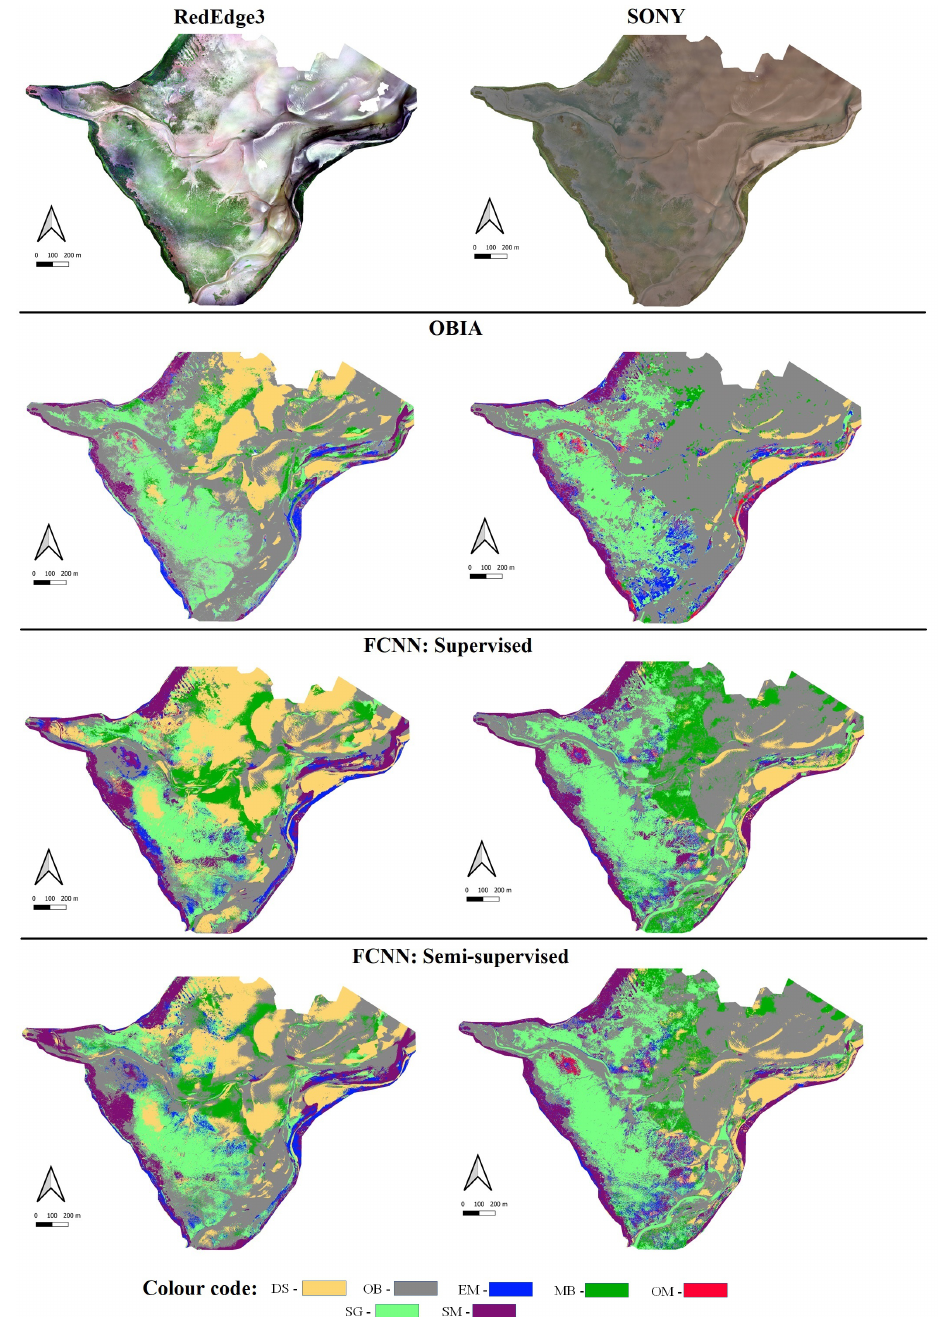
Figure 9. Segmented habitat maps for both cameras and methods. The top row—RedEdge3 and SONY cameras orthomosaics. The second row—habitat maps using the OBIA approach. The third row—FCNN maps in a supervised setting. The bottom row—FCNN maps in a semi-supervised set- ting. The left column—RedEdge3 images and segmented maps, the right column—the SONY images and maps. Legend: OM—Other Macroalgae inc. Fucus ; MB— Microphytobentos ; EM— Enteromorpha ; SM—Saltmarsh; SG—Seagrass; DS—Dry Sand; OB—Other